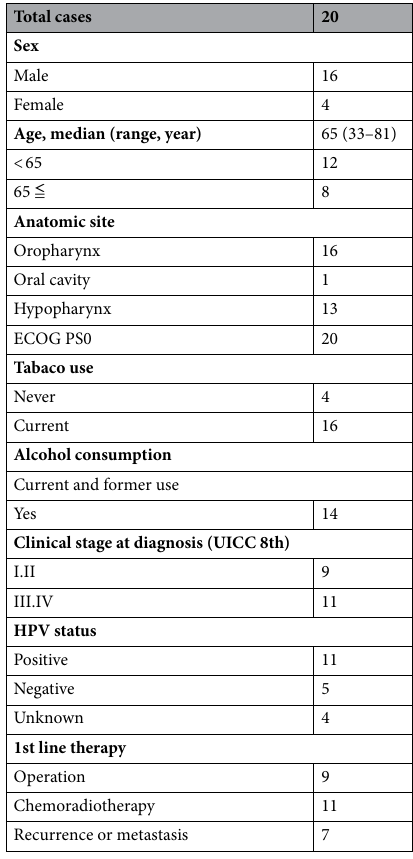
Table 1. Patient characteristics. UICC Union for International Cancer Control.